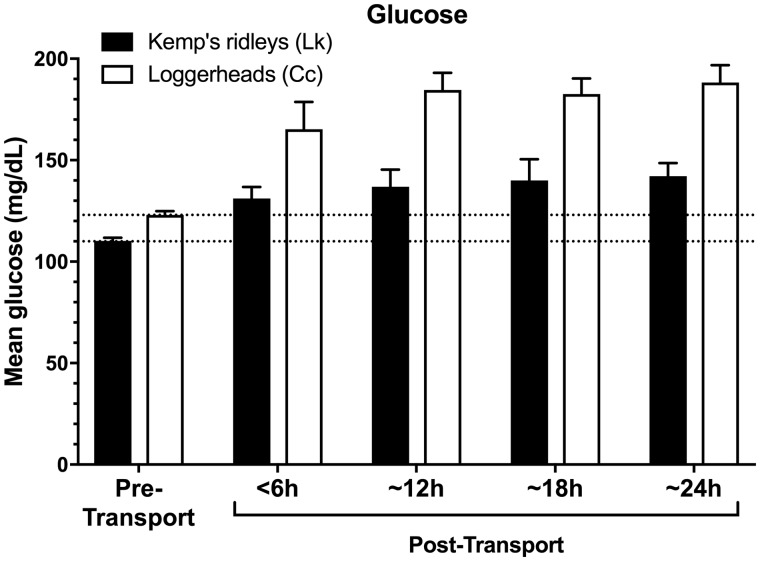
Post-transport glucose in Kemp’s ridley and loggerhead turtles when compared with pre-transport baselines. Dashed lines indicate pre-transport means (i.e., bars on left), for visual comparison to post-transport concentrations in both species. Bars indicate means±SEM.